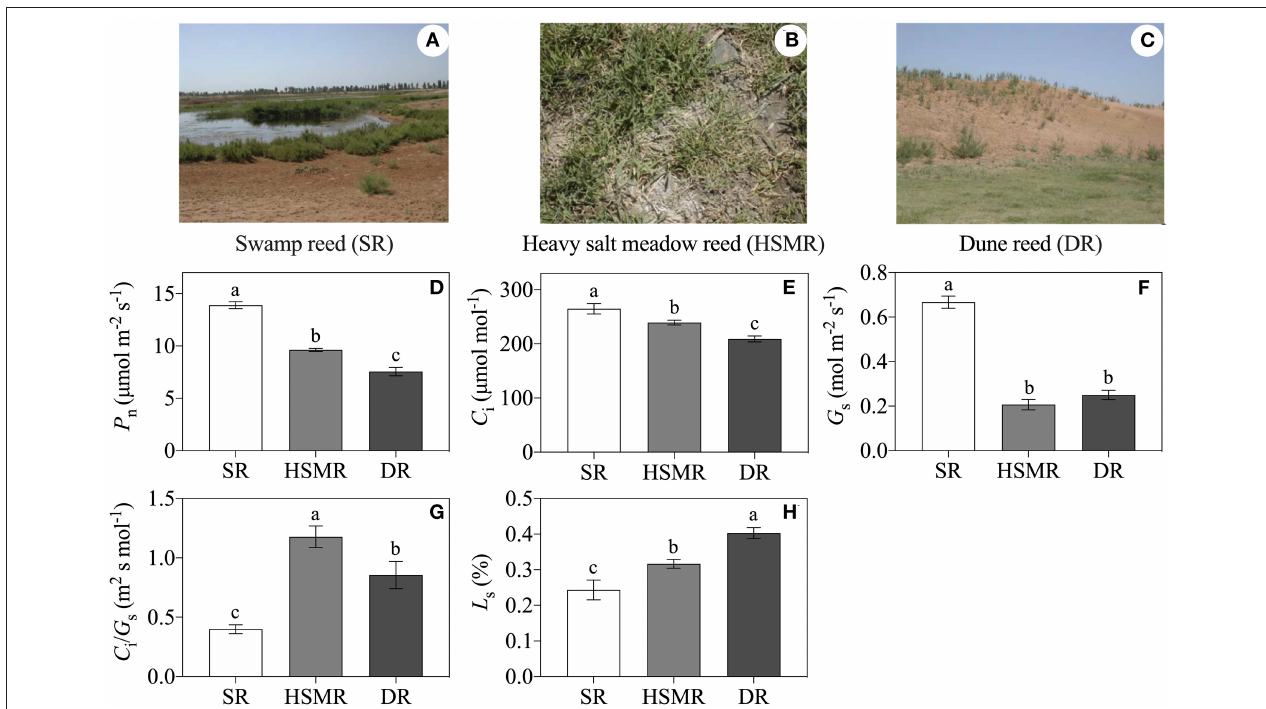
FIGURE 1 | The habitats and physiological variations in three different ecotypes of reed. (A) Swamp reed (SR); (B) heavy salt meadow reed (HSMR); (C) dune reed (DR); (D) net photosynthetic rate ( P n ); (E) intercellular CO 2 concentration ( C i ); (F) stomatal conductance ( G s ); (G) ratio of C i / G s ; and (H) stomatal limitation ( L s ). Different lowercase letters at the data indicate significant differences among three different ecotypes of reed at p < 0.05 (one-way ANOVA). The photographs of three different ecotypes of reed were taken by Xue-Yi